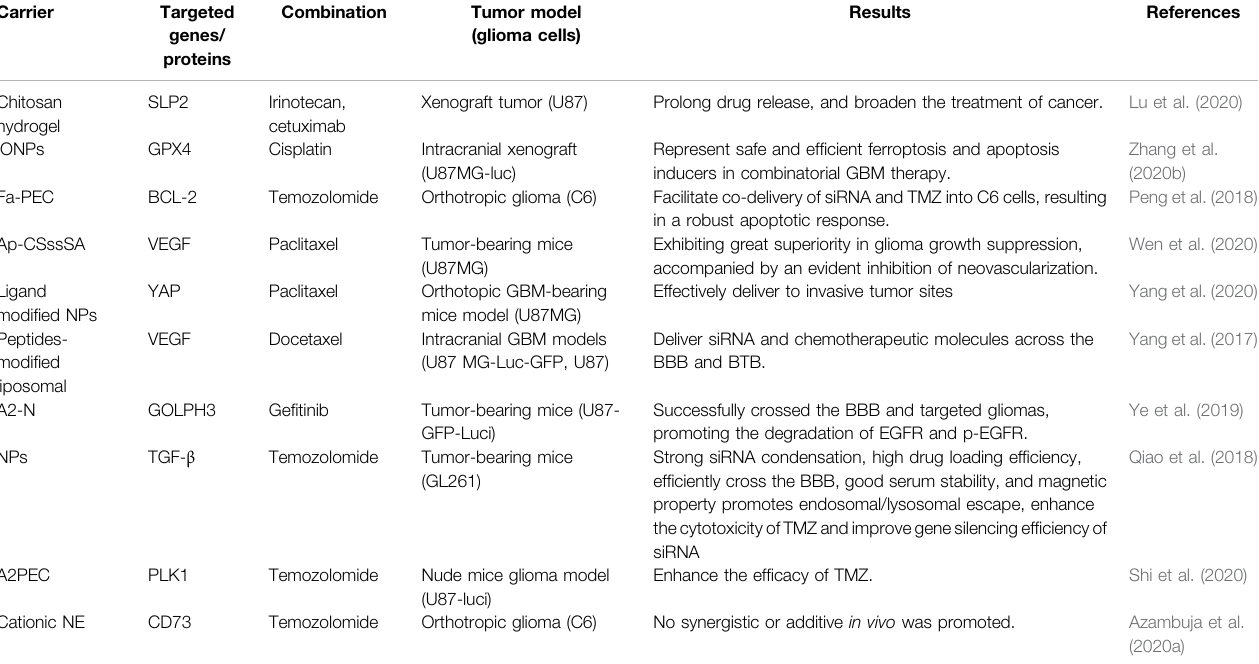
TABLE 2 | Co-delivery of siRNA and anti-cancer compounds.